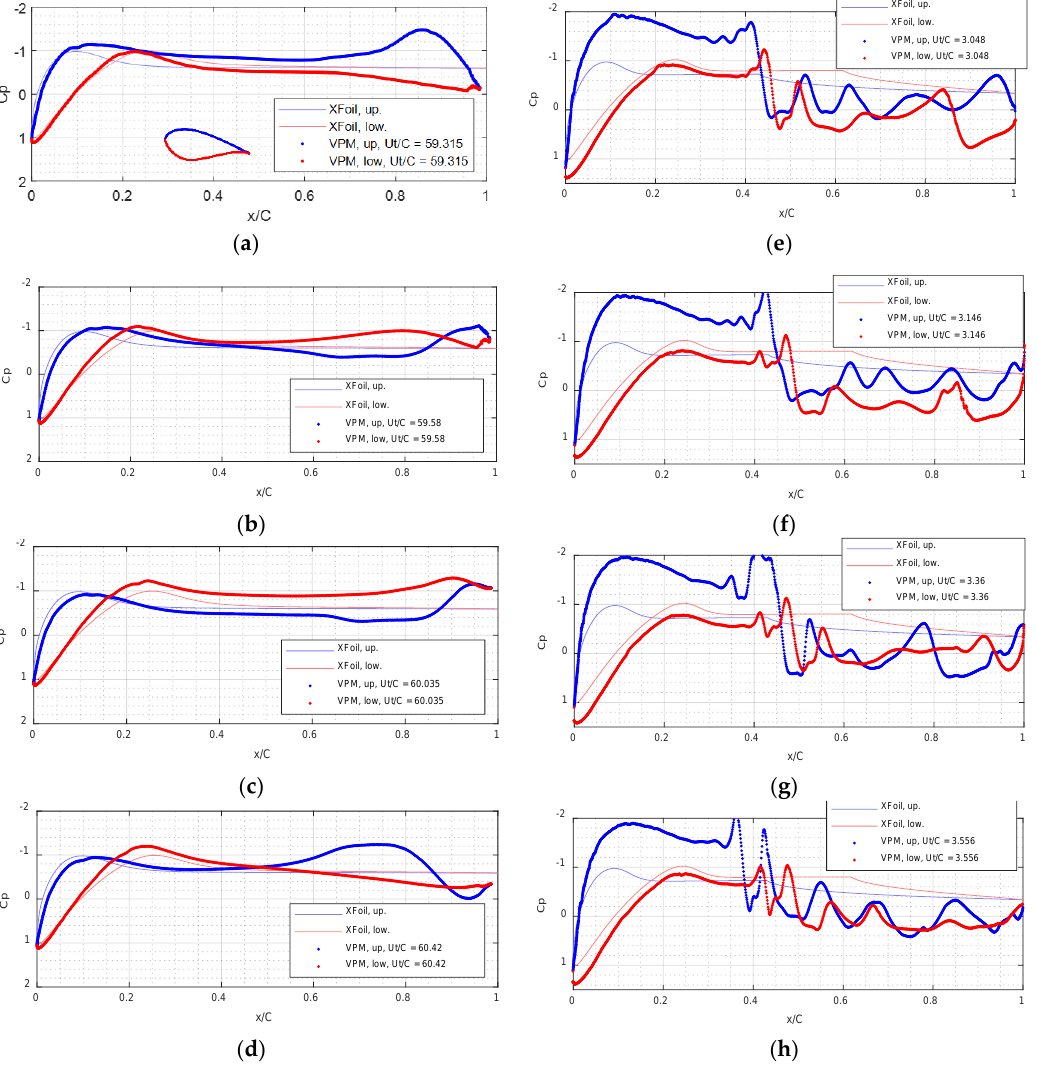
, , Rec = 60,000 and Ut / C α = 10° α = 0°